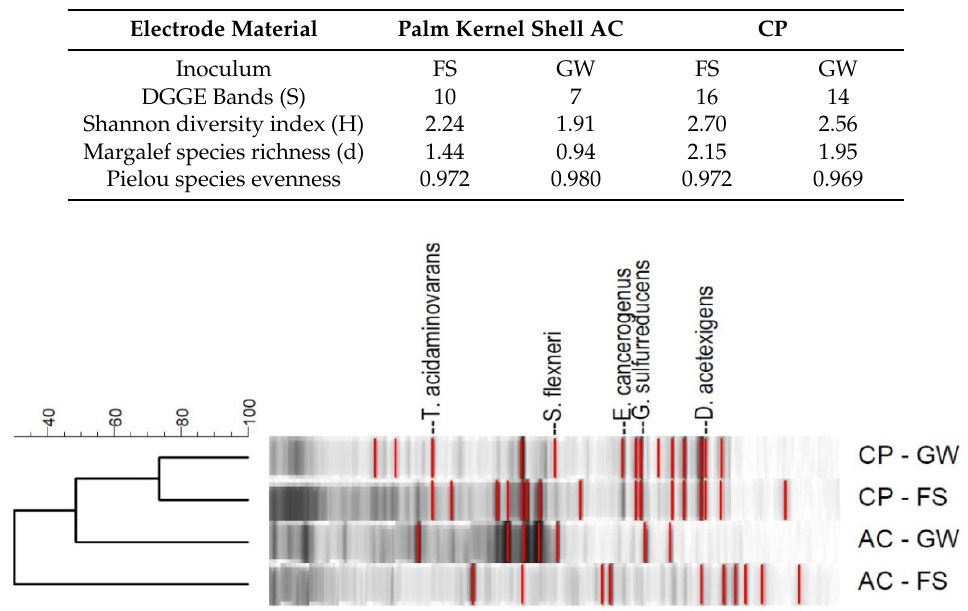
Figure 4. DGGE gel band image for the analyzed electrode biofilms (horizontal labels indicate the biofilm samples for CP and palm kernel shell AC inoculated with GW and